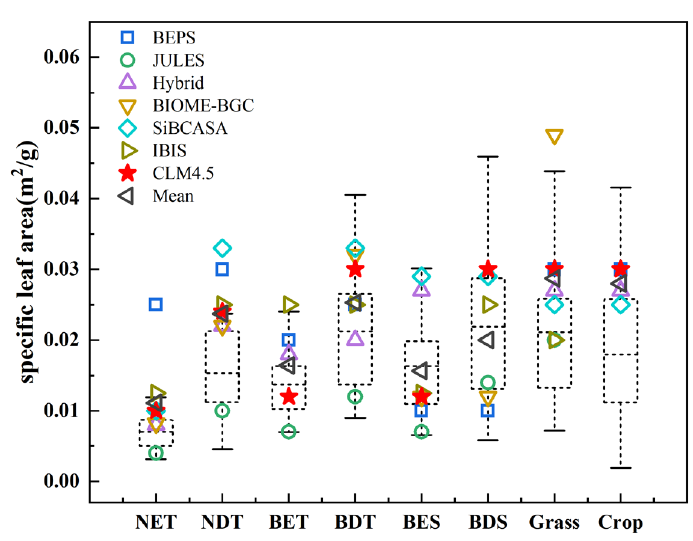
Figure 4. The default SLA values in terrestrial biosphere models and the SLA mean observed values in China for different plant functional types. Box plots show the mean, 25th percentile, and 75th percentile of the observed SLA values. Abbreviations: NET, needleleaf evergreen tree; NDT, needleleaf deciduous tree; BET, broadleaf evergreen tree; BDT, broadleaf deciduous tree; BES, broadleaf evergreen shrub; BDS, broadleaf deciduous shrub.